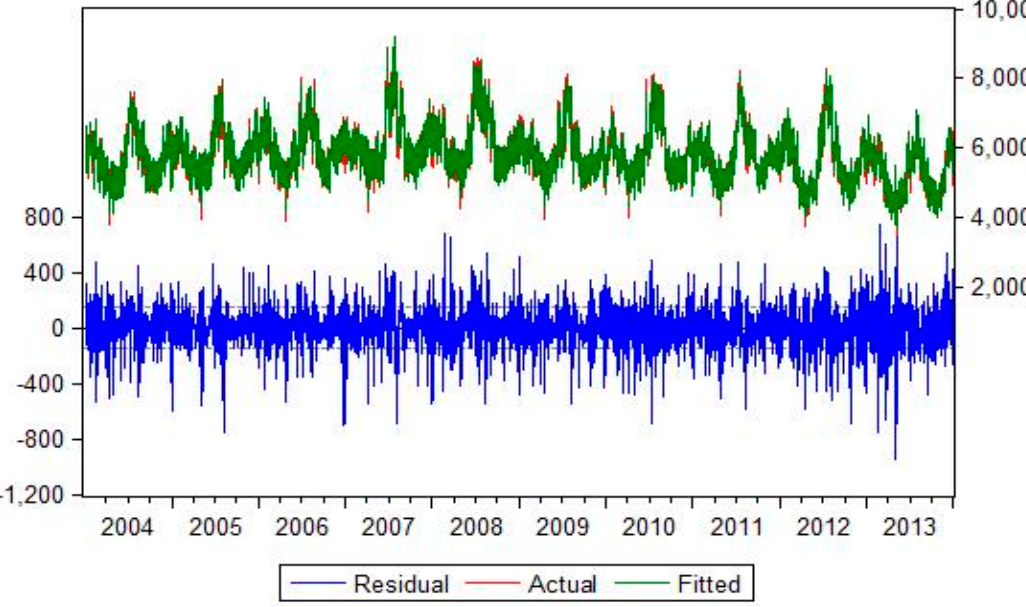
Figure 14. Fitted in ‐ sample SARIMAX series to actual load for years 2004–2014.